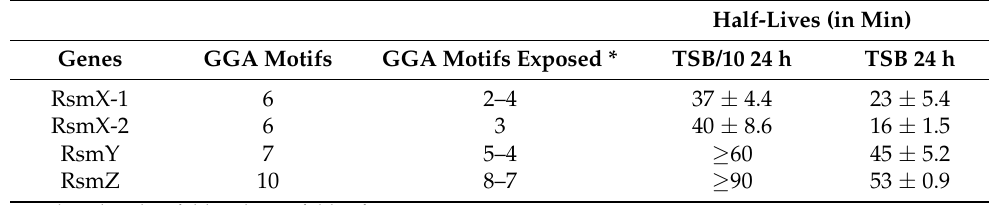
Table 3. Rsm sRNAs stability is correlated to the number of GGA motifs. Relationships between